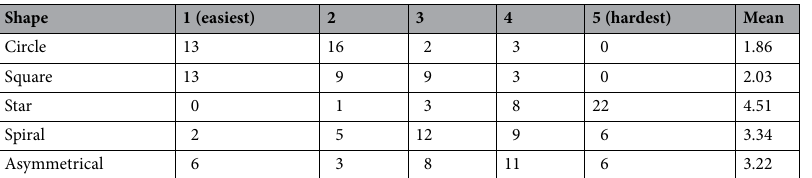
Table 1. Study participant’s responses in the questionnaire. Participants were asked to assign a number from one to five to each shape in ascending order of difficulty. The table shows how many participants assigned each number to each